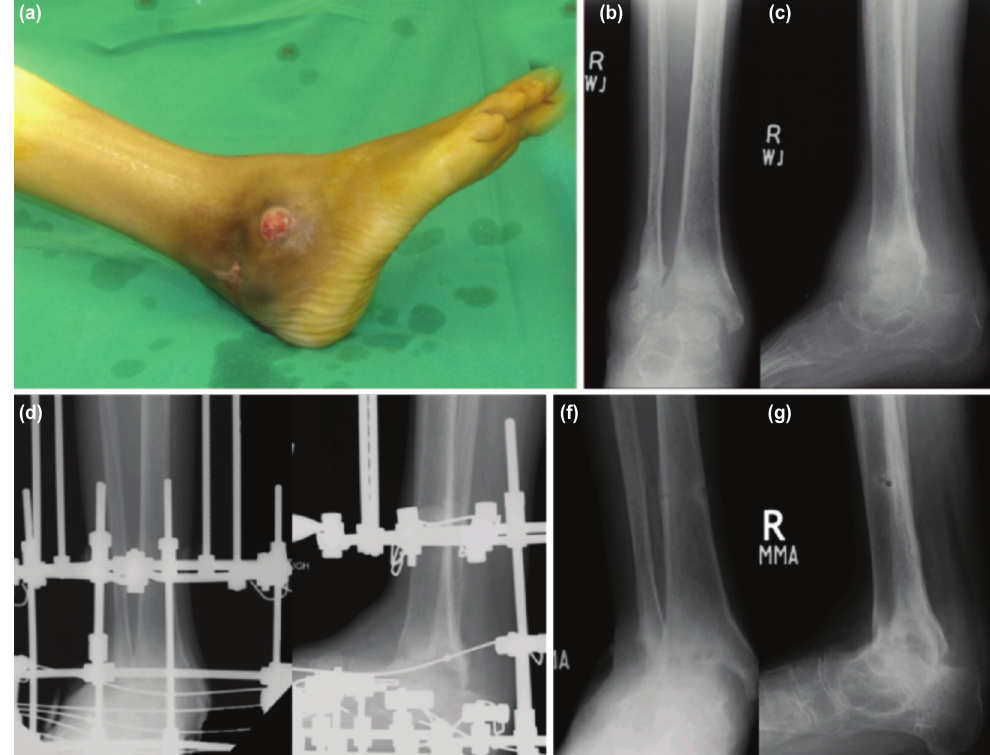
(a) Intra-operative photograph of 45 year-old lady with tuberculosis ankle joint showing ulcers at ankle. (b,c) Pre-operative Fig. 1: radiographs Ilizarov anteroposterior and lateral views showing subchondral erosions and sclerosis. (d,e) Immediate post- operative radiographs showing Ilizarov fixator across ankle joint Ilizarov anteroposterior and lateral views. (f,g) Nine months post-operative radiographs Ilizarov anteroposterior and lateral views after removal of Ilizarov fixator showing ankle joint fusion.